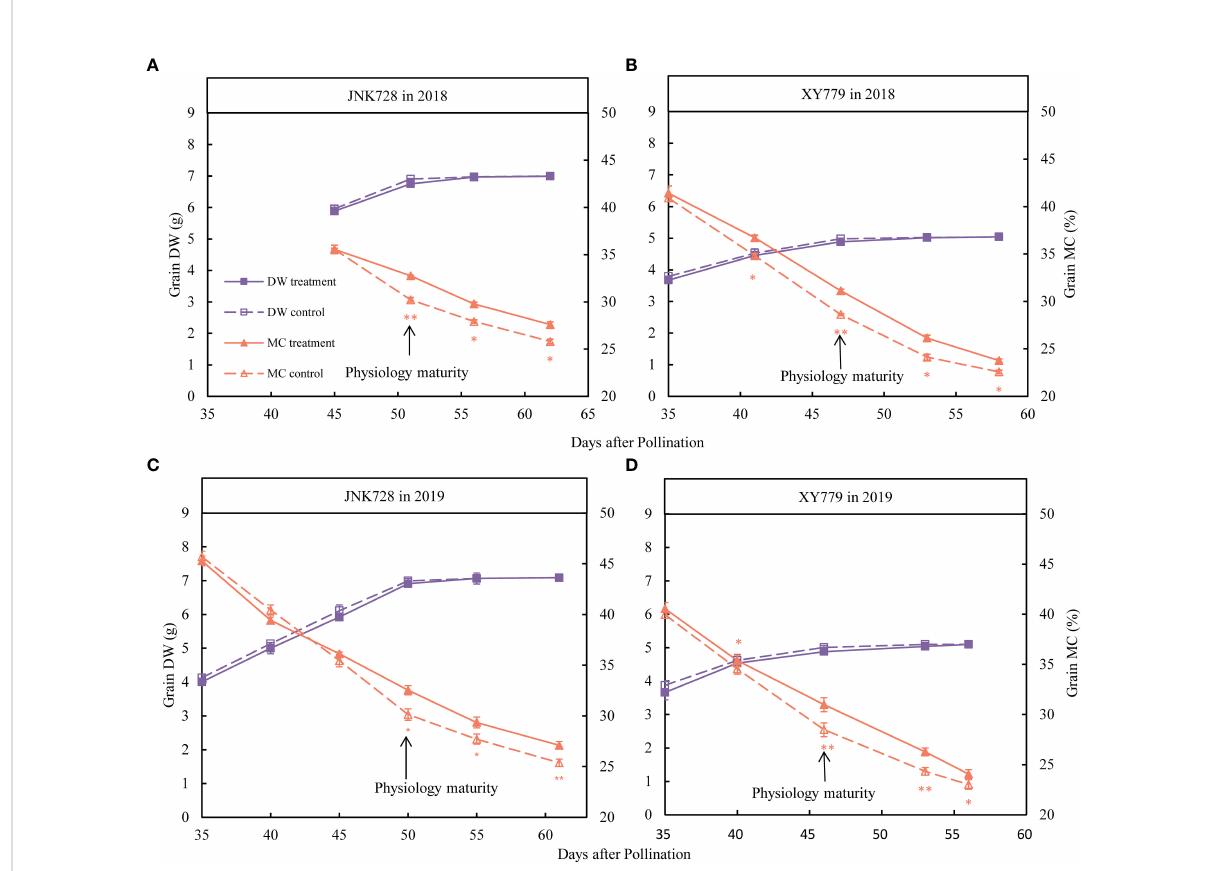
FIGURE 4 The Paired Samples T-test analysis showing the dry weight (DW) and moisture content (MC) of the 20 grains of the treatment and control collected from (A, C) JNK728 and (B, D) XY779, each, between the late stages of grain fi lling in 2018 and 2019. The single asterisk “ * ” indicates signi fi cance at 0.05, while the double asterisk “ ** ” indicates signi fi cance at the 0.01 probability levels. The values are presented as means ± SE